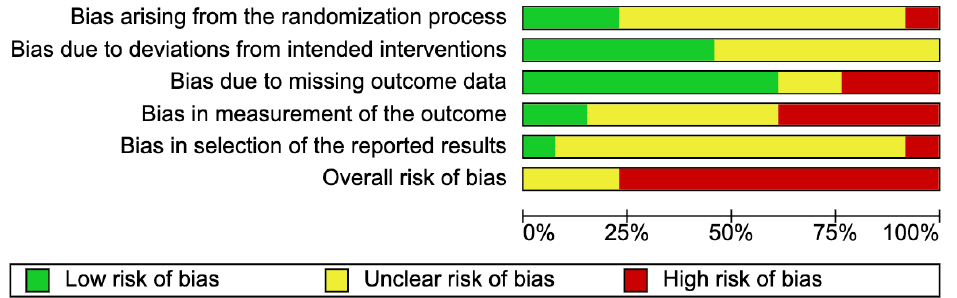
Figure 1. Preferred Reporting Items for Systematic Reviews and Meta-Analyses (PRISMA) flowchart showing the steps of study inclusion [36].